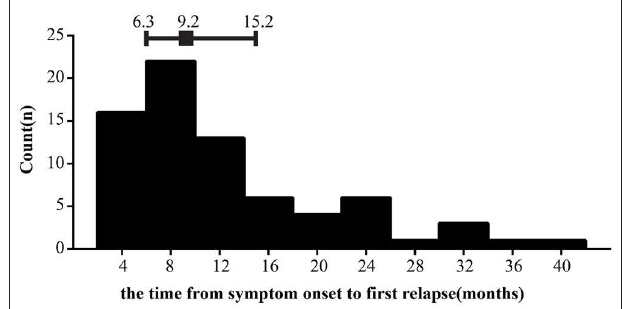
FIGURE 2 | Distributions of the interval time from symptom onset to first relapse. Error bars show median surrounded by 25th and 75th percentiles.